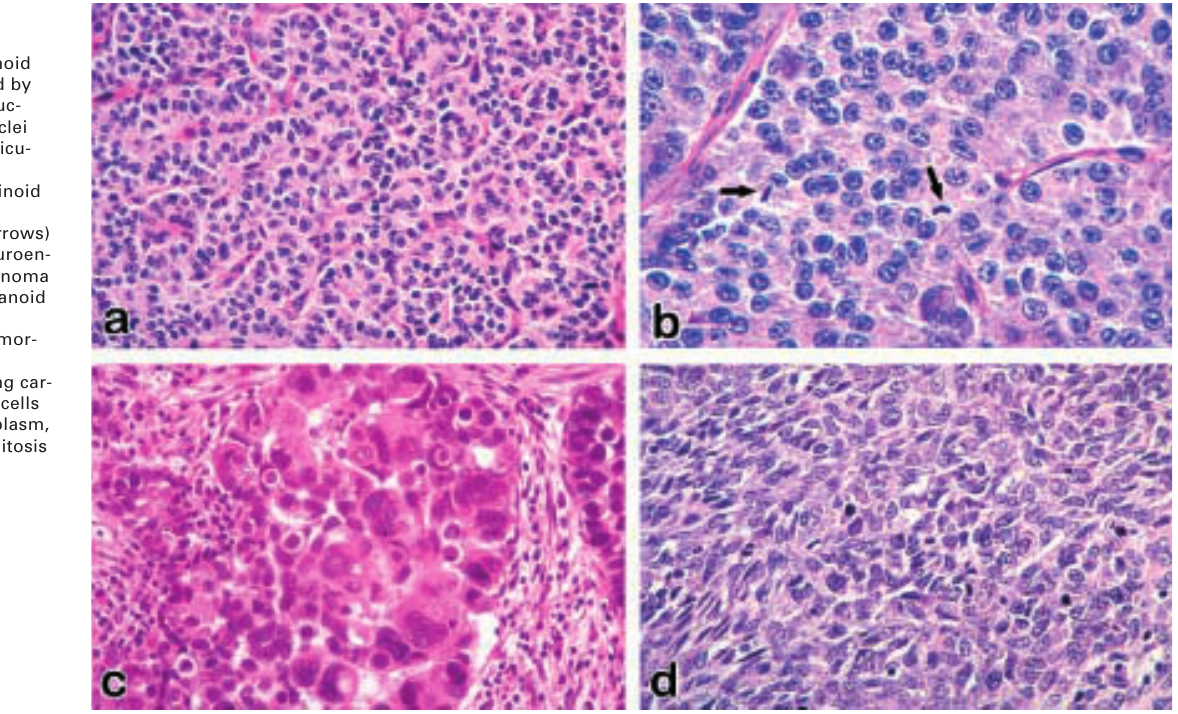
Figure 1 (HE, 40 (cid:2) ) a typical carcinoid characterised by organoid struc- tures and nuclei with inconspicu- ous nucleoli b atypical carcinoid with mitosis (shown by arrows) c large cell neuroen- docrine carcinoma showing organoid pattern and nuclear pleomor- phism d small cell lung car- cinoma with cells lacking cytoplasm, number of mitosis >10/2 mm 2